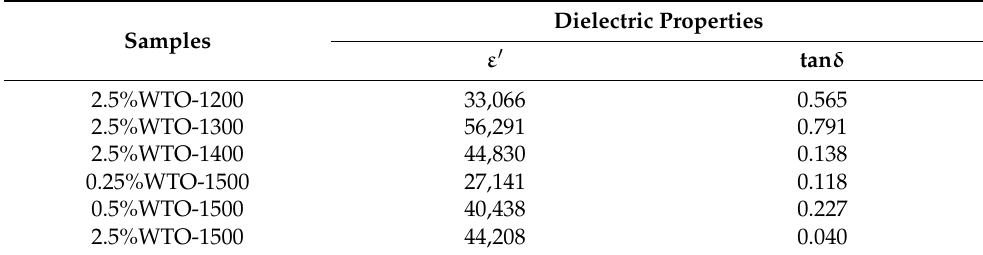
Table 2. Dielectric properties ( ε (cid:48) and tan δ ) of all ceramic samples at room temperature (RT) and 1